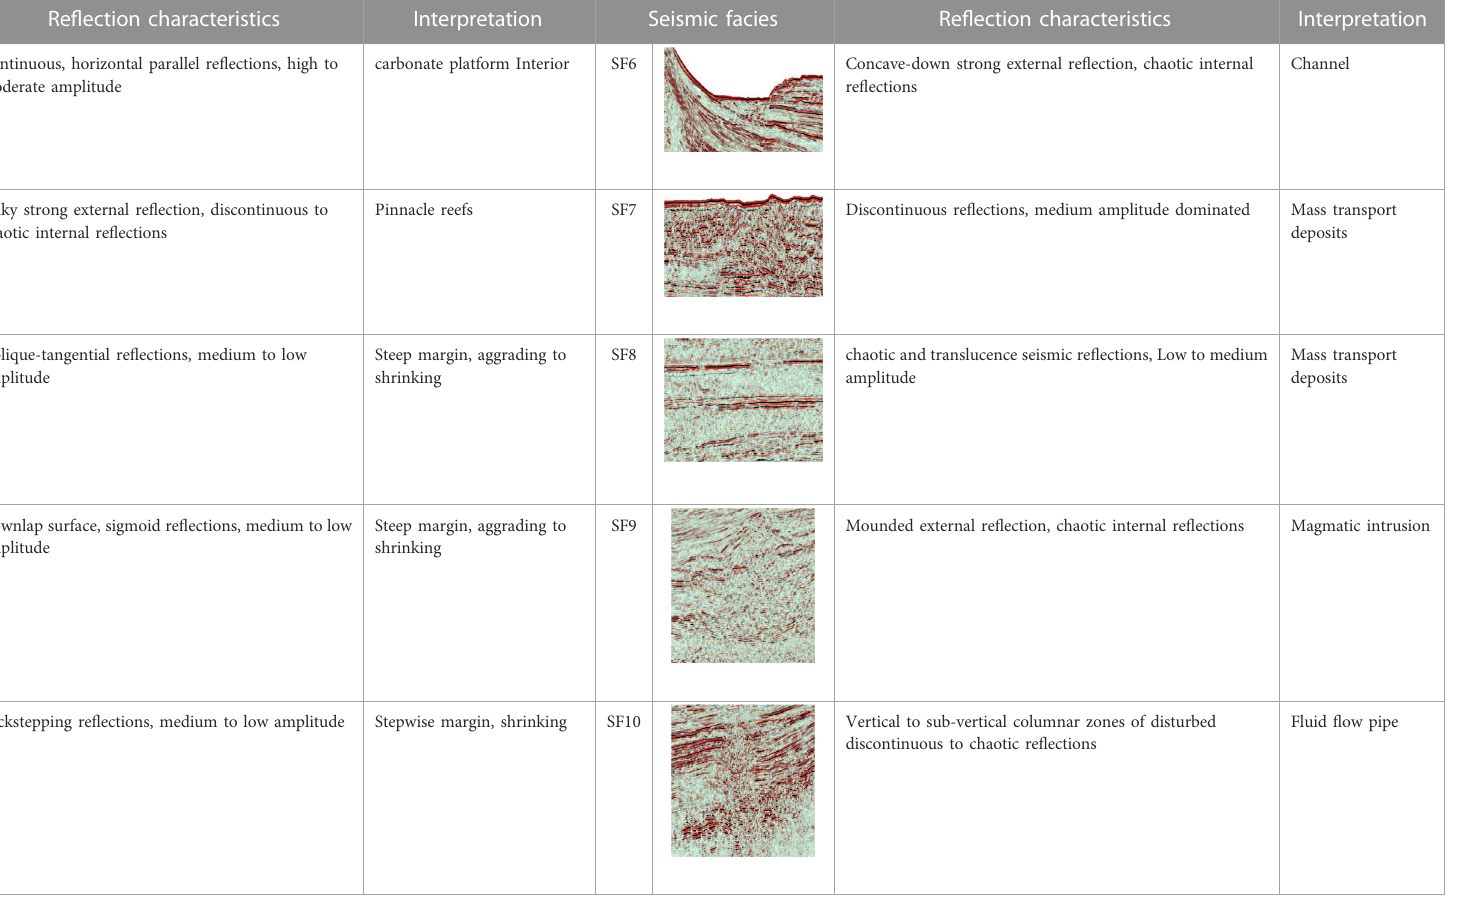
TABLE 1 Description and interpretation of seismic facies (SF) in multi-channel seismic pro fi